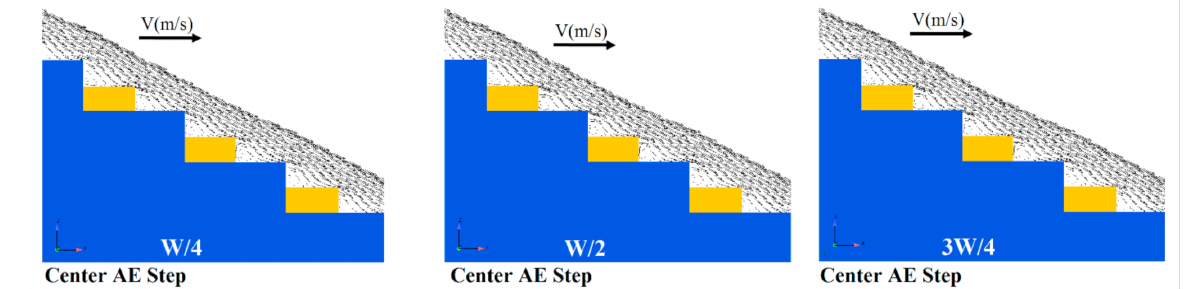
Figure 10. Instantaneous streamlines in the transverse direction.